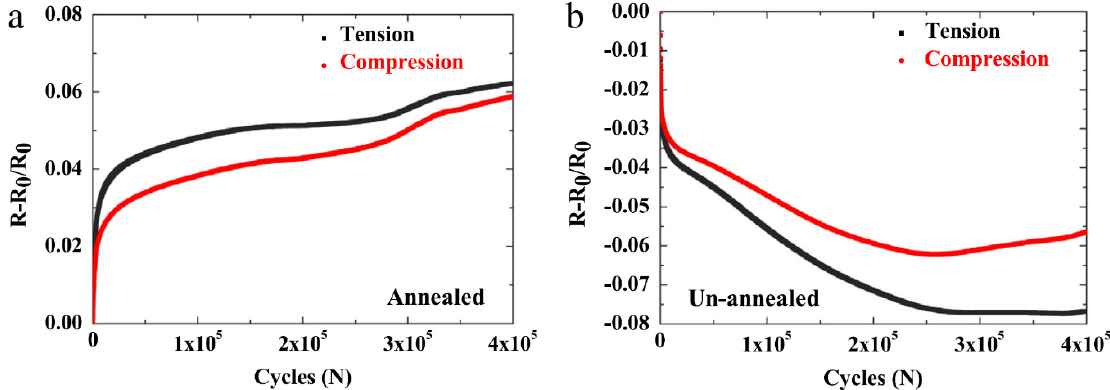
Figure 10. Resistance change of ( a ) annealed and ( b ) un-annealed silver nanowire networks under cyclic bending. Repro- duced with permission from ref. [43]. Copyright 2016, Elsevier.